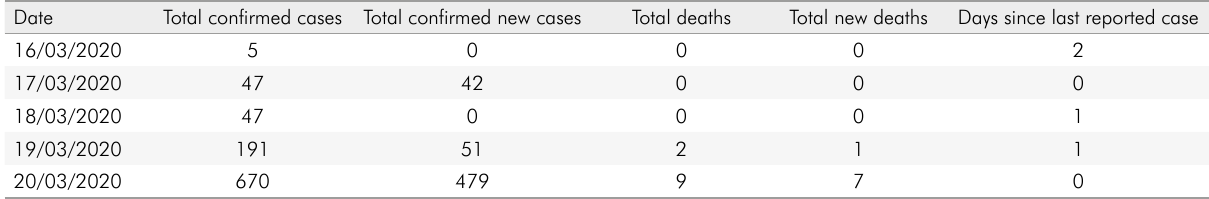
Table 5. The number of COVID-19 cases day by day in Turkey at the time of the data collection of the present study according to WHO. Total confirmed cases Total confirmed new